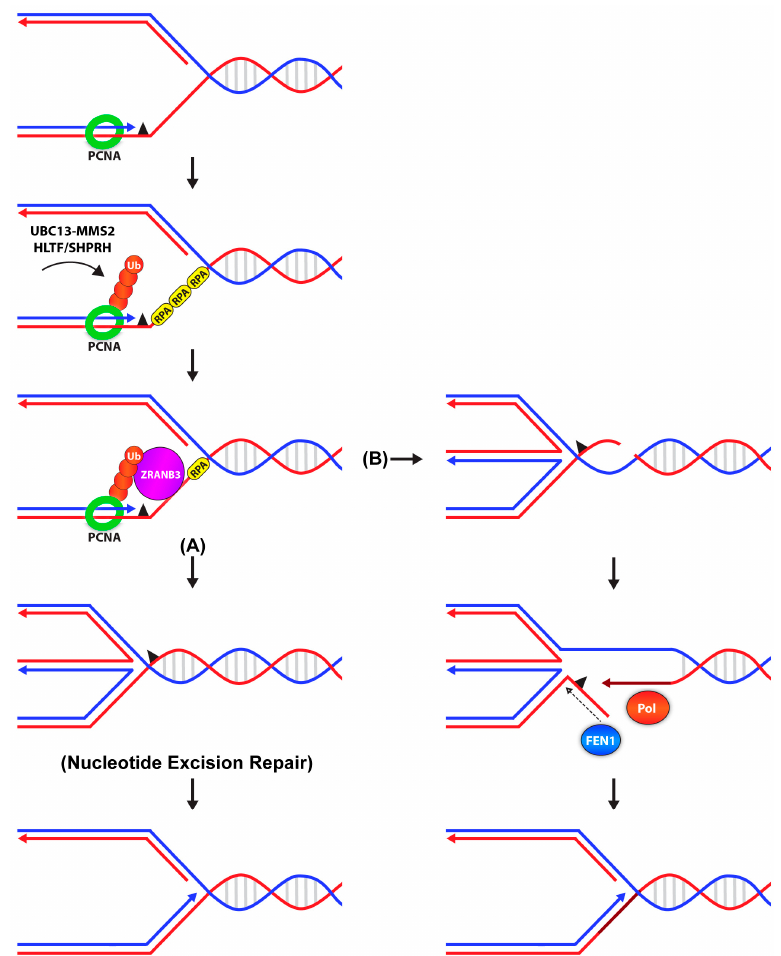
Figure 2. Error-free lesion bypass by ZRANB3. Upon replication fork stalling, PCNA is mono-ubiquitinated by the RAD6-RAD18 complex. K63-linked poly-ubiquitin chains are added by UBC13-MMS2 with the ubiquitin ligase, HLTF or SHPRH. ZRANB3 then binds to poly-ubiquitinated PCNA via its PIP, APIM and NZF motifs and ( A ) facilitates fork reversal. The remaining lesion will be processed by NER. ( B ) Alternatively, ZRANB3 acts as a structure-specific endonuclease and induces a DNA break, two nucleotides into the parental duplex, exposing a free 3 ′ OH group. Fork reversal occurs to stabilize the fork while the free 3 ′ OH is extended by DNA polymerase, displacing the lesion into a 5 ′ flap. The 5’ flap is then processed by FEN1, removing the lesion. DNA replication resumes following nick sealing and fork reversal. Model B is adapted from Weston et al., 2012, 26,